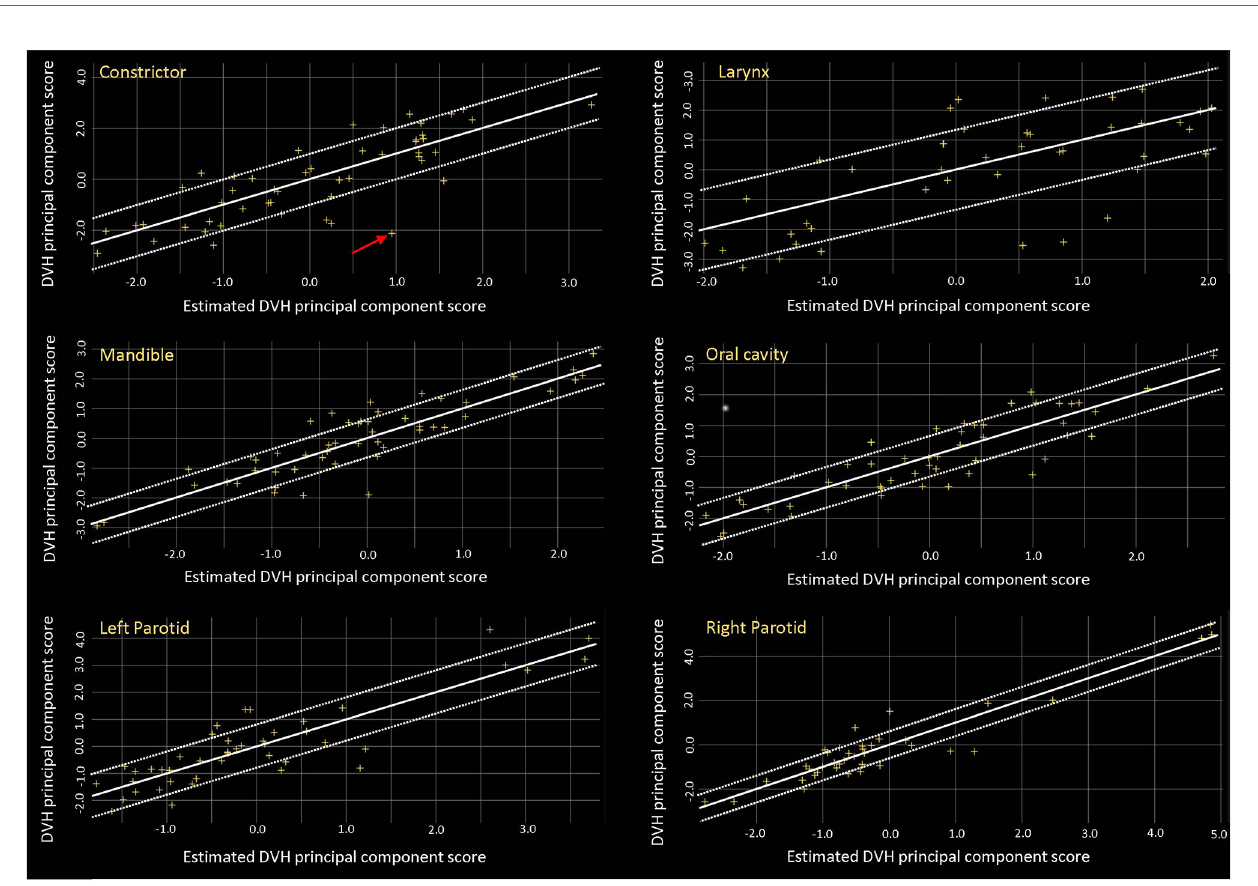
FIGURE 1 | Residual plots for some of the OARs. OARs, organs at risk.